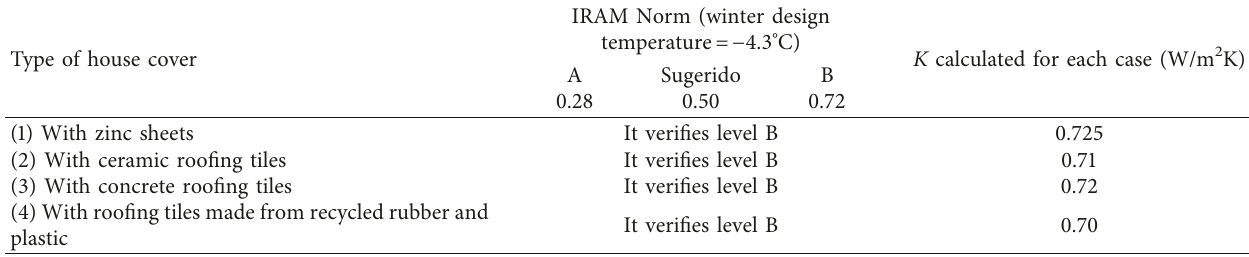
Table 4: Thermal transmittance coefficients, K , for different types of house cover. Type of house cover